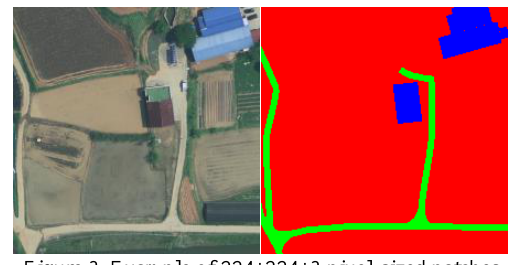
Figure 3. Example of 224*224*3 pixel-sized patches